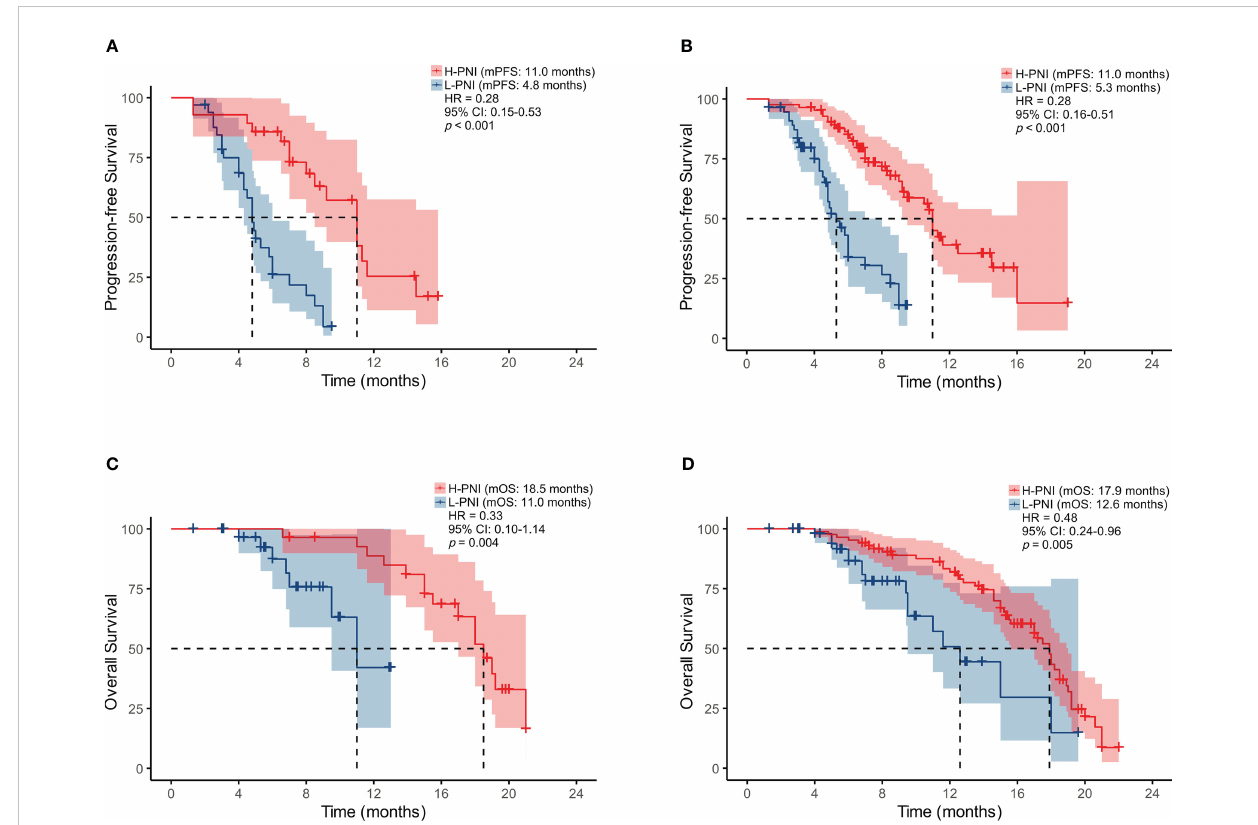
FIGURE 2 Kaplan-Meier survival curves displaying PFS according to PNI group in SCLC patients treated with (A) PD-L1/PD-1 inhibitors monotherapy or (B) combined with chemotherapy; OS by PNI group in SCLC patients treated with (C) PD-L1/PD-1 inhibitors monotherapy or (D) combined with chemotherapy.